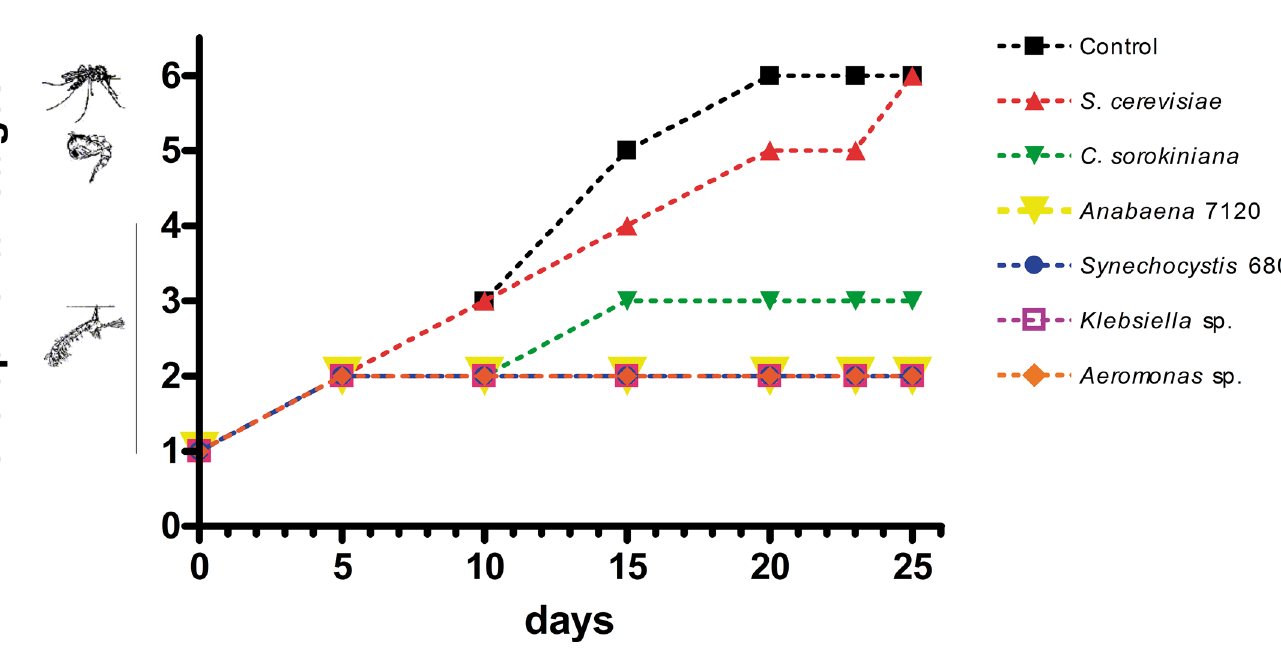
PLOS ONE | DOI:10.1371/journal.pone.0153133 April 7,